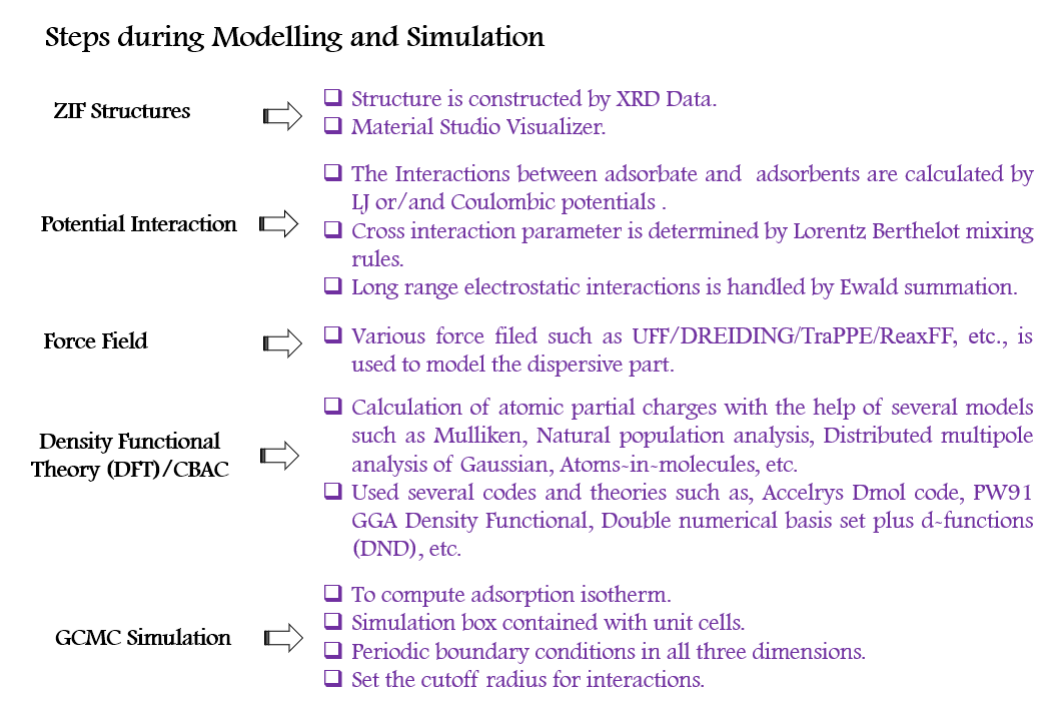
Figure 8. The steps during computational modelling and simulation on ZIFs.